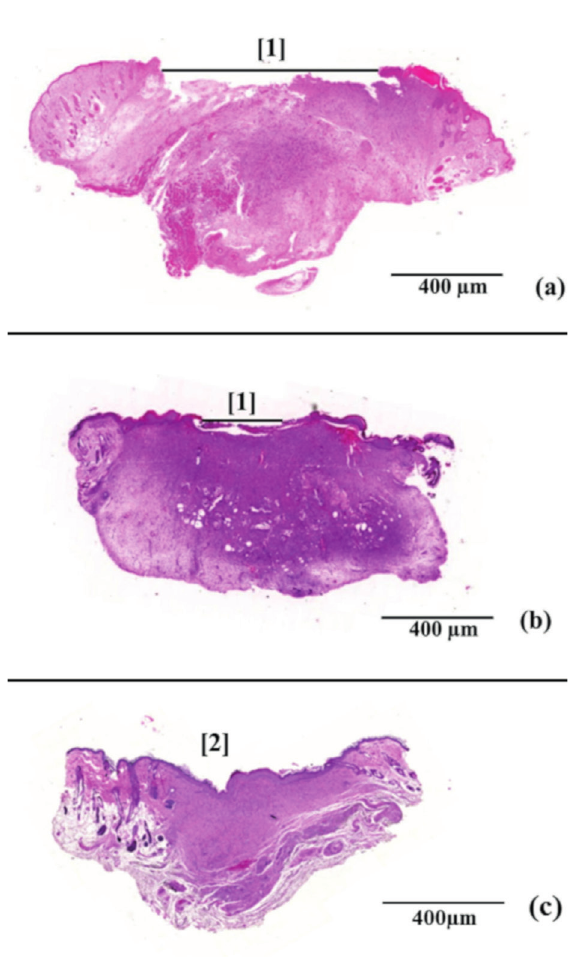
Figure 2 - Histological Sections of dorsal skin of mice showing the saline solution group ( a ), dexpanthenol group ( b ) and AelAs cream group ( c ). All images show the extent of re-epithelialization after 15 days of treatment: [1] distance between the epithelium and [2] total re-epithelialization. He staining. Magnification